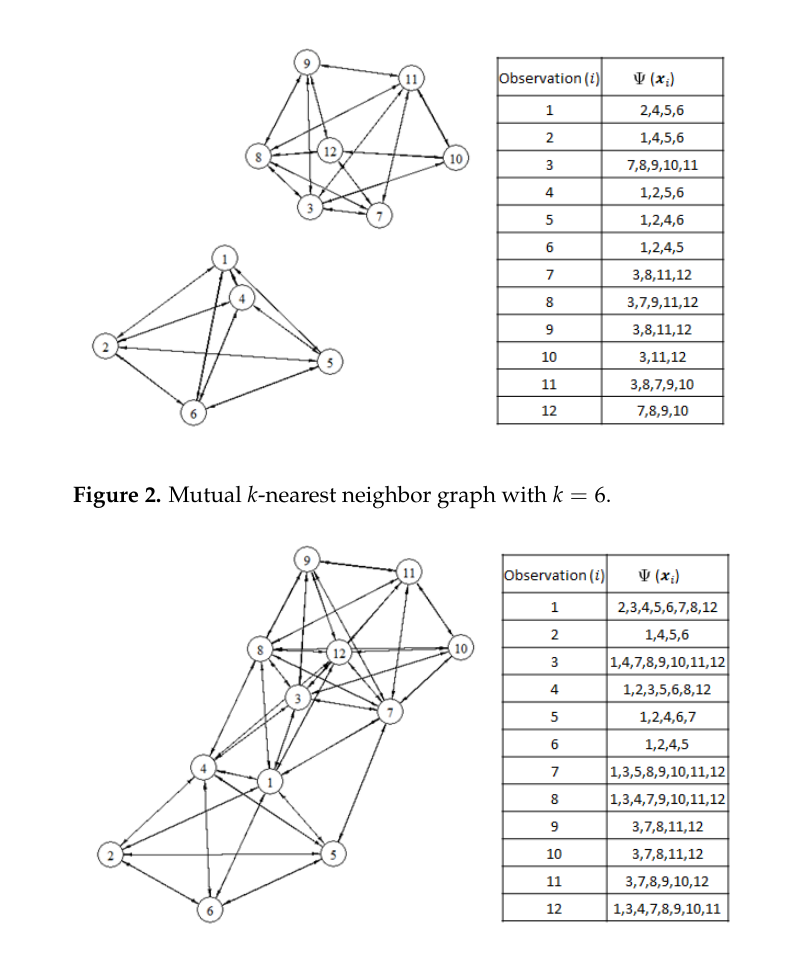
Figure 3. Mutual k -nearest neighbor graph with k =